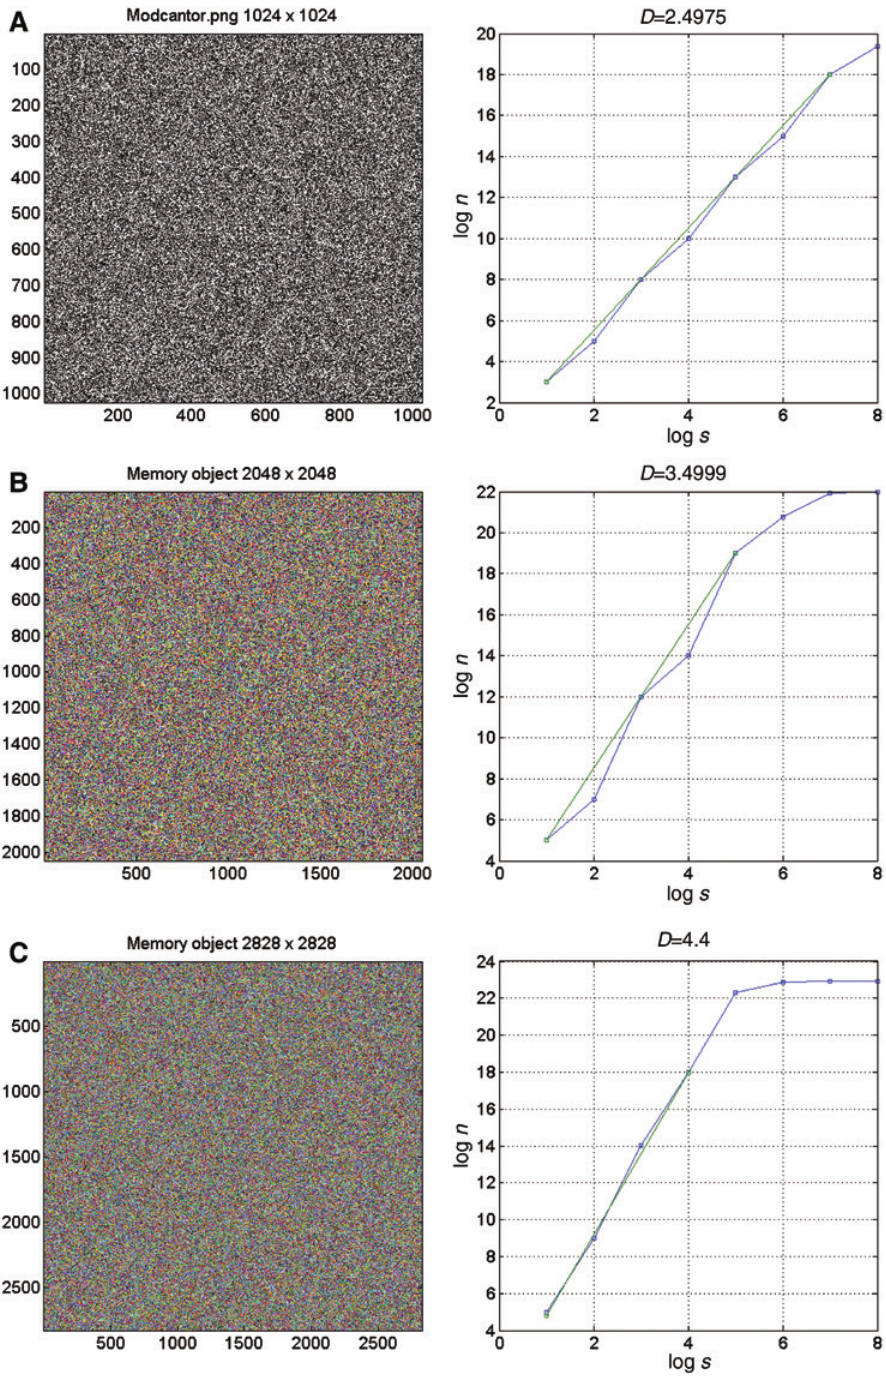
Figure 4: Images with known fractional fractal dimensions. (A) Monochrome intensity is random Cantor set with D = 0.5 ( D = 2.5). (B) R, G and B are random Cantor sets ( D = 3.5). (C) R is random Cantor set, G and B are noise ( D =